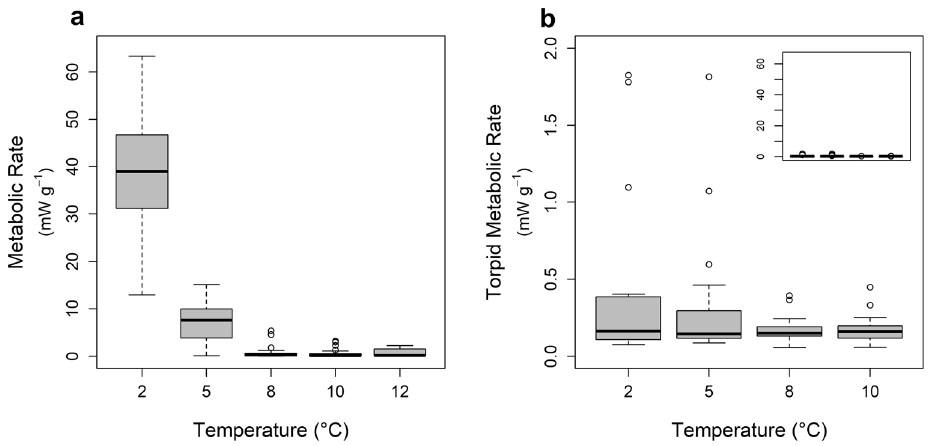
Figure 2. Examples of metabolic responses to decreasing temperature. ( a ) Tadarida brasiliensis aroused at temperatures below 8 °C, indicating the minimum defended temperature was between 5 and 8 °C. Most species in our study did not arouse at colder temperatures, but we often detected increased torpid metabolic rate at colder temperatures. ( b ) The minimum defended temperature for Myotis ciliolabrum was < 2 °C and we did not detect any differences in TMR over the range 2 and 10 °C. Note the very low metabolic rate of torpid bats (typical of most bats in our study); the inset in panel b plots the same data, but on the same scale as panel a for